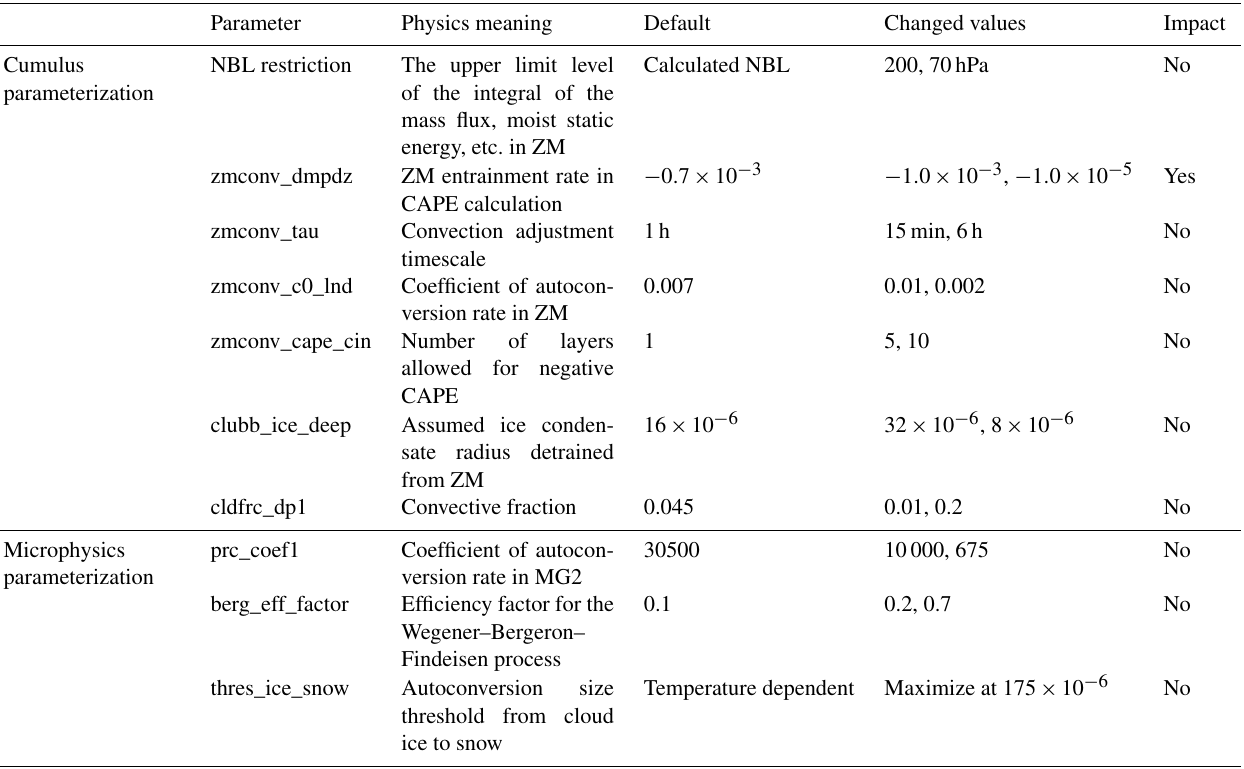
Table 3. Changes of the tunable parameters in the sensitivity tests for echo top height.